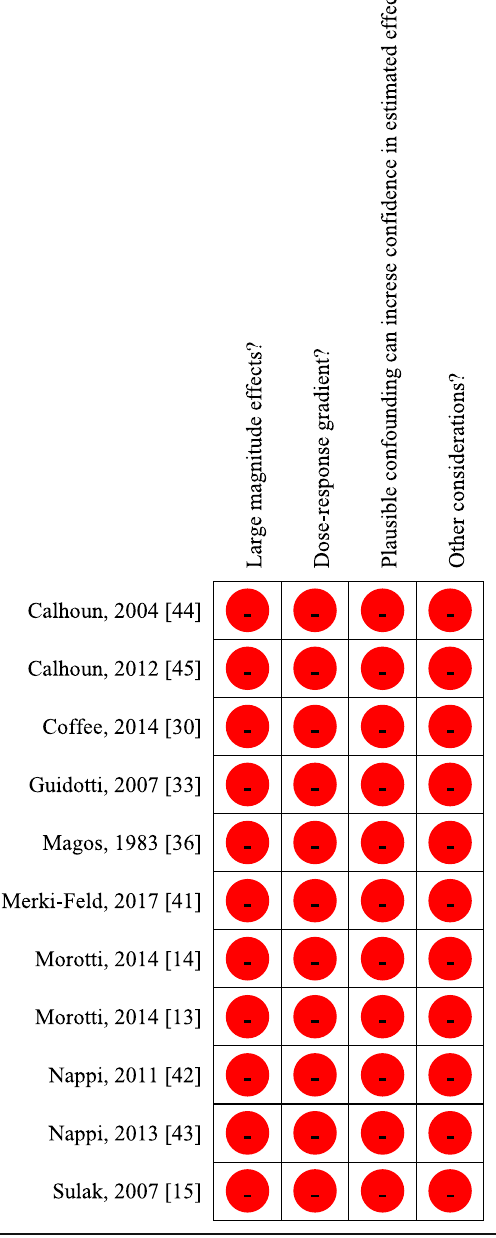
individual observational